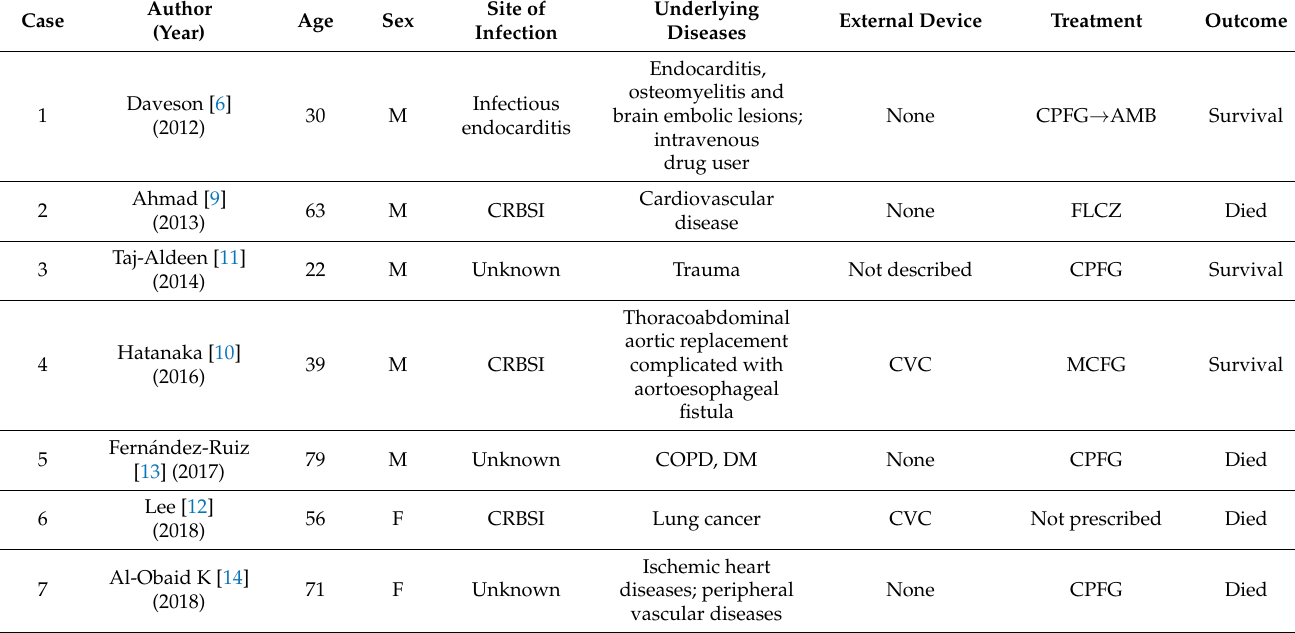
Table 1. Cases of Lodderomyces elongisporus fungaemia previously